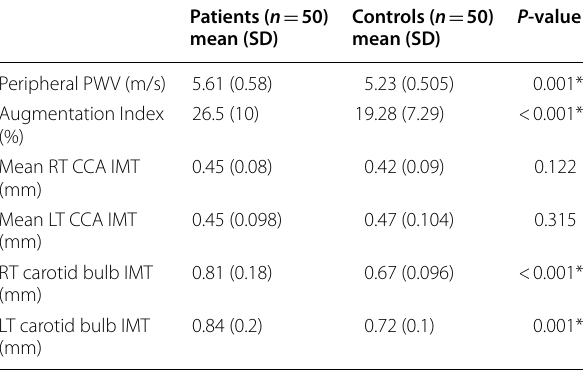
Table 3 Vascular function of patients with multiple sclerosis and control